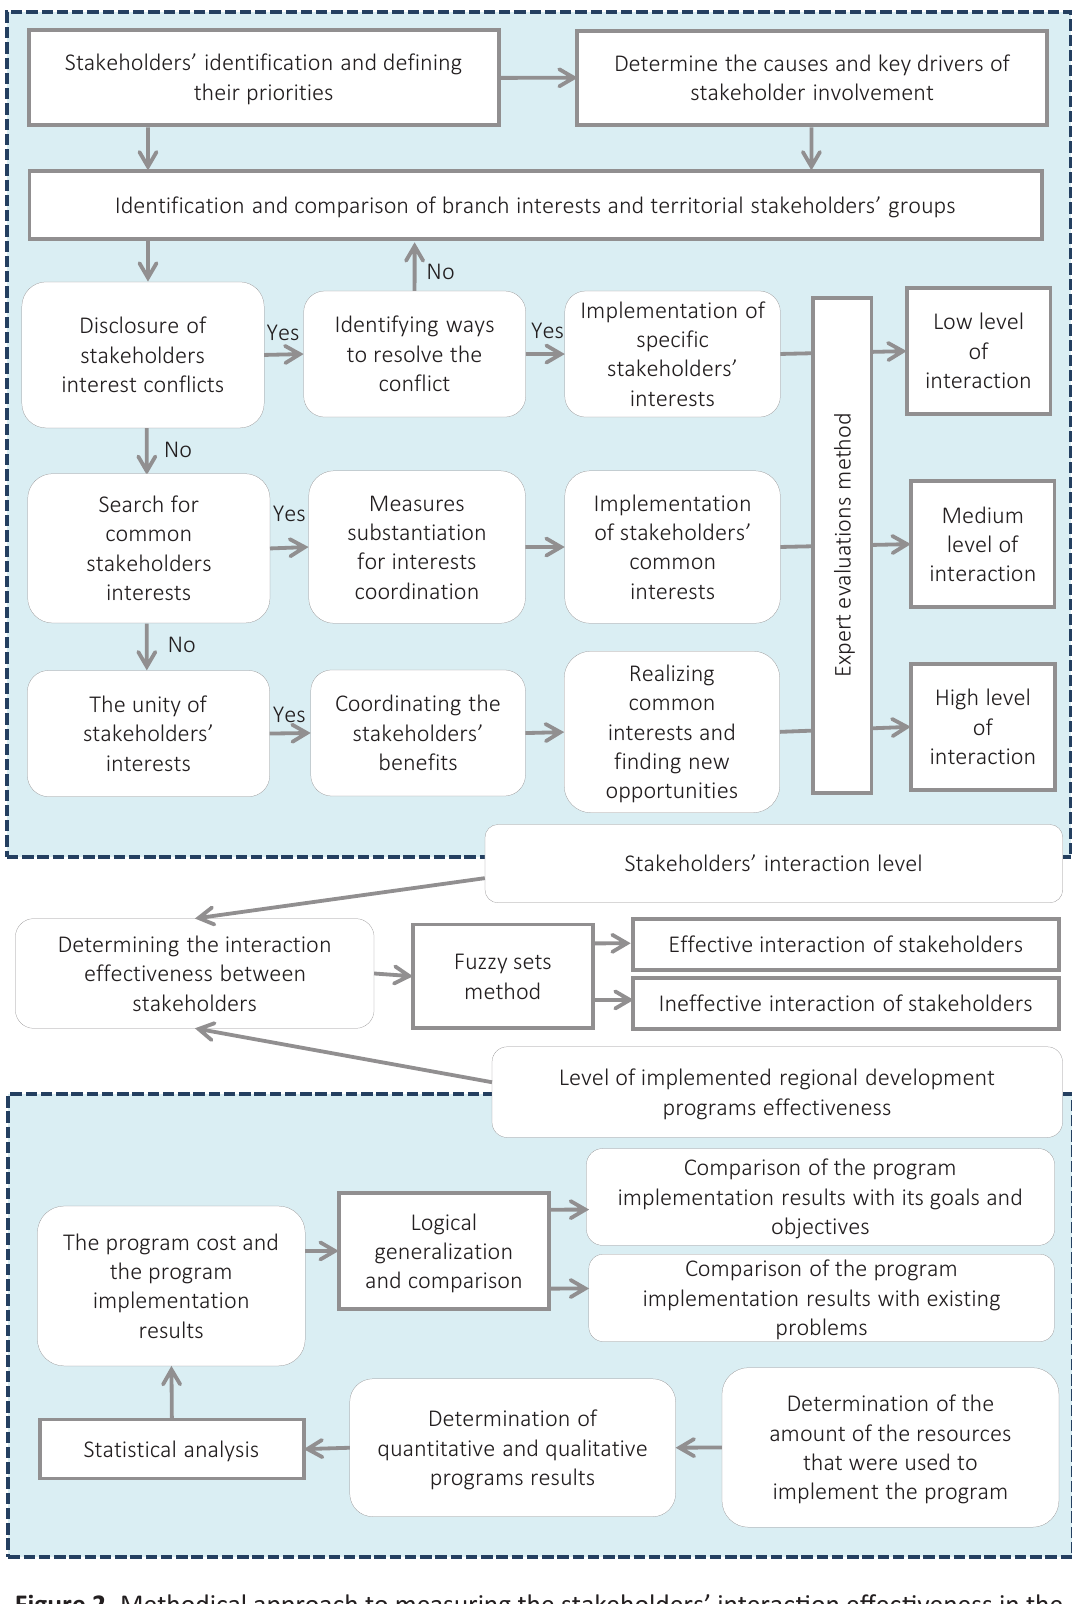
Figure 2. Methodical approach to measuring the stakeholders’ interaction effectiveness in